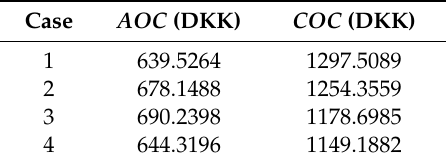
Table 5. The AOC s and COC s of CCHP micro-grid for Cases 1–4 on the typical winter day.